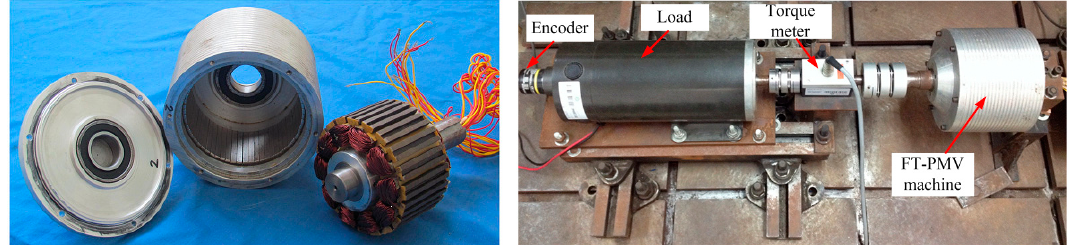
Figure 7. Experimental setup.